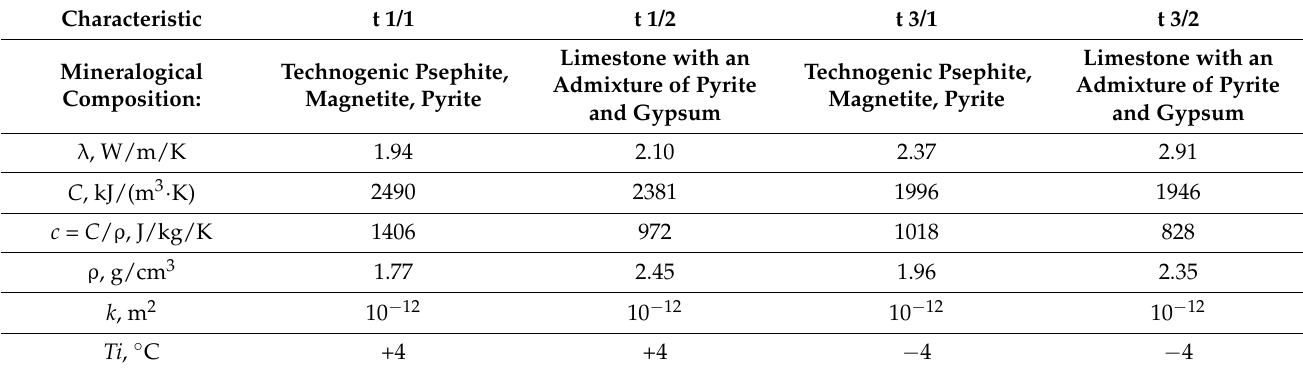
Table 1. Thermophysical characteristics of the wells’ units adopted for physical